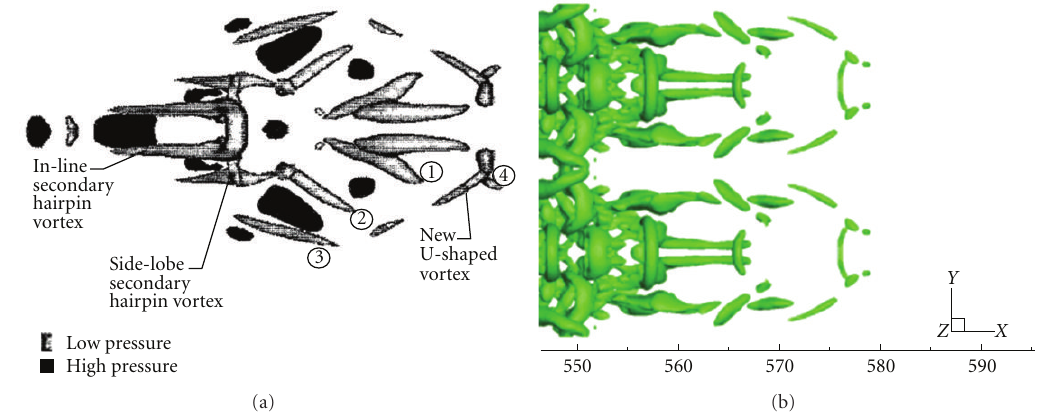
Figure 21: (a) U-shaped vortex [9], (b) DNS with a di ff erent λ -value (fake).